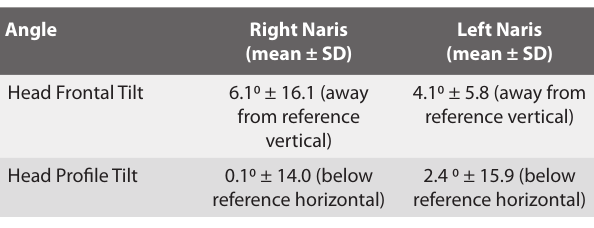
Table 2. Position of patient’s head relative to vertical reference line on the wall.